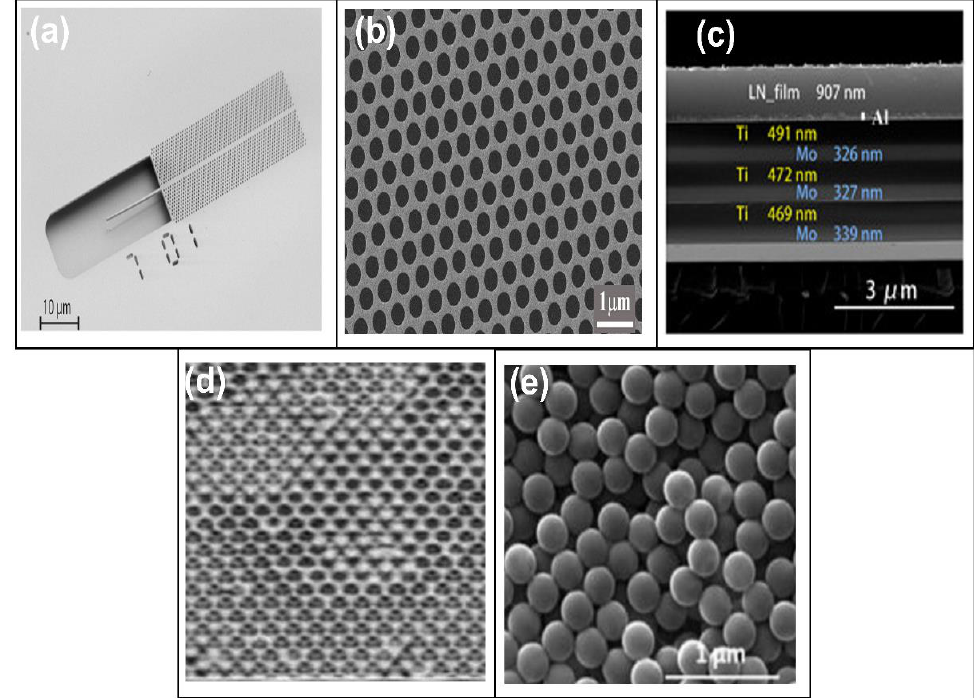
Figure 7. Photonic Crystals. ( a ) SEM image of a fabricated 2D PhC slab. ( b ) A representative SEM image of the nanohole PhC arrays (D = 350 nm). ( c ) Cross-sectional image of the LN thin film and the metallic multilayers (Bragg reflector). ( d ) Scanning electron micrographs of inverse opal I. ( e ) SEM of colloidal PhCs. ( a ) Reprinted with permission from [100], copyright 2019, Wiley; ( b ) reprinted with permission from [101], copyright 2022, Degruyter; ( c ) reprinted with permission from [102], copyright 2020, AIP; ( d ) reprinted with permission from [103], copyright 2009, IPS; ( e ) reprinted with permission from [104], copyright 2021, Elsevier.